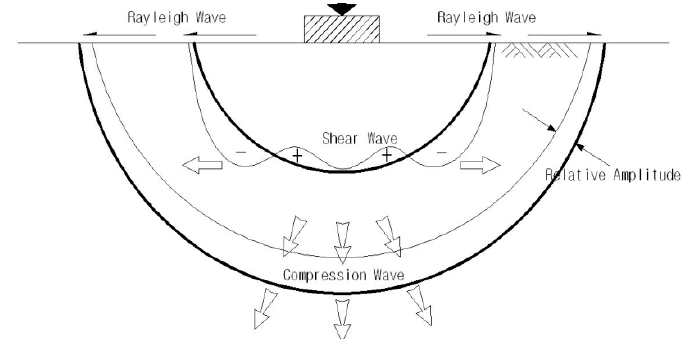
Figure 6. Shape of wave propagation generated by dynamic compaction [9].